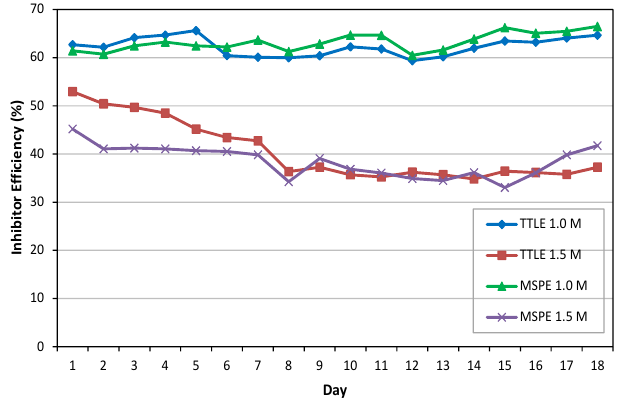
Fig. 5. Plot showing variation of inhibition efficiency with time at room temperature.